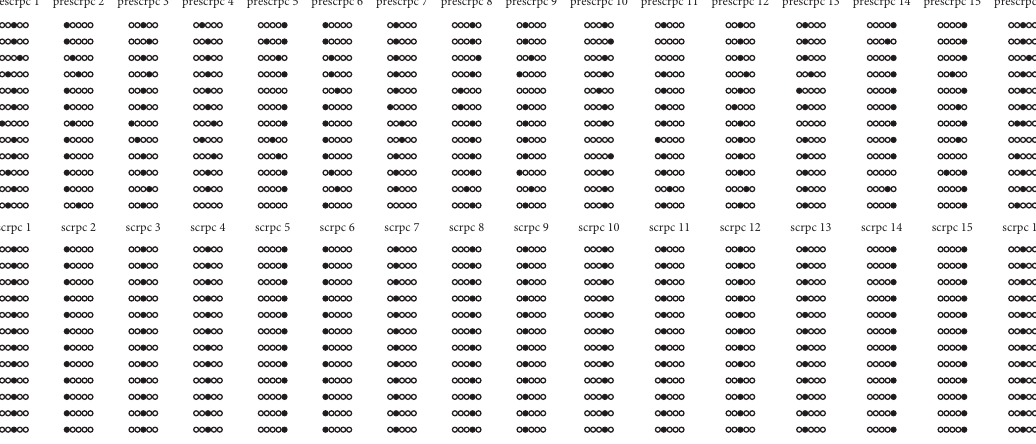
Figure 6: Simulation results of supply chain risk prevention and control index